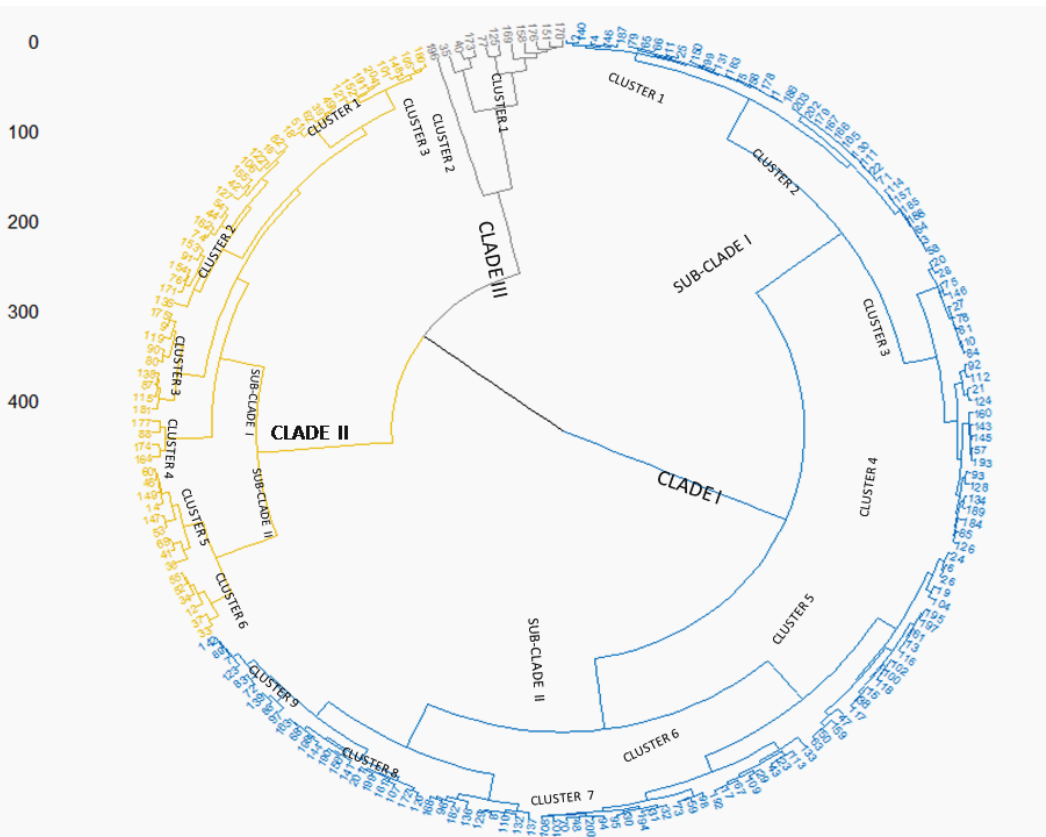
Figure 4. Hierarchical clustering of 204 V.radiata genotypes based on derived stress indices. Four de- rived stress analysis parameters (GP: Germination percentage, Germination stress tolerance index: GSTI, SHSI: Seedling height shoot index, PCI: Productive capacity index, RCI: Resilience capacity index;